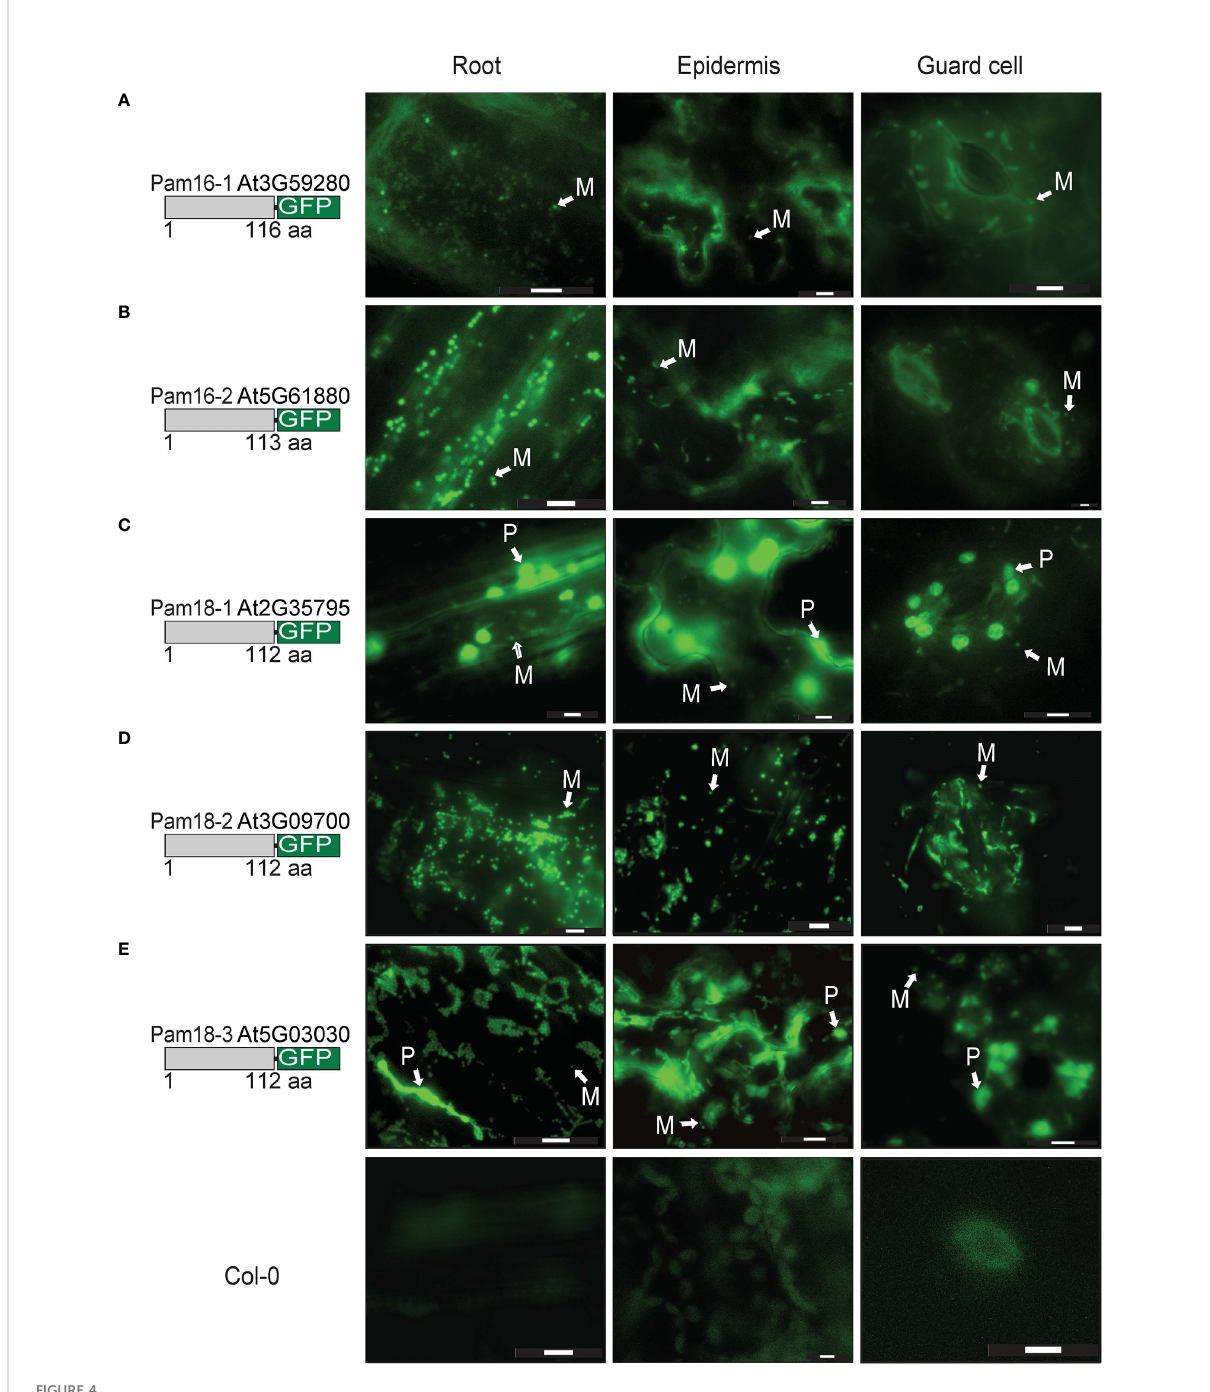
FIGURE 4 Pam16 and Pam18 GFP in stable transgenic Arabidopsis seedlings. Images taken from 3 weeks old Arabidopsis T2 transformants of root, epidermal, and guard cells Pam16-1 (A) . Pam16-2 (B) . Pam18-1 (C) . Pam18-2 (D) . Pam18-3 (E) . Scale bar indicates 20 m M. M, mitochondria, P,